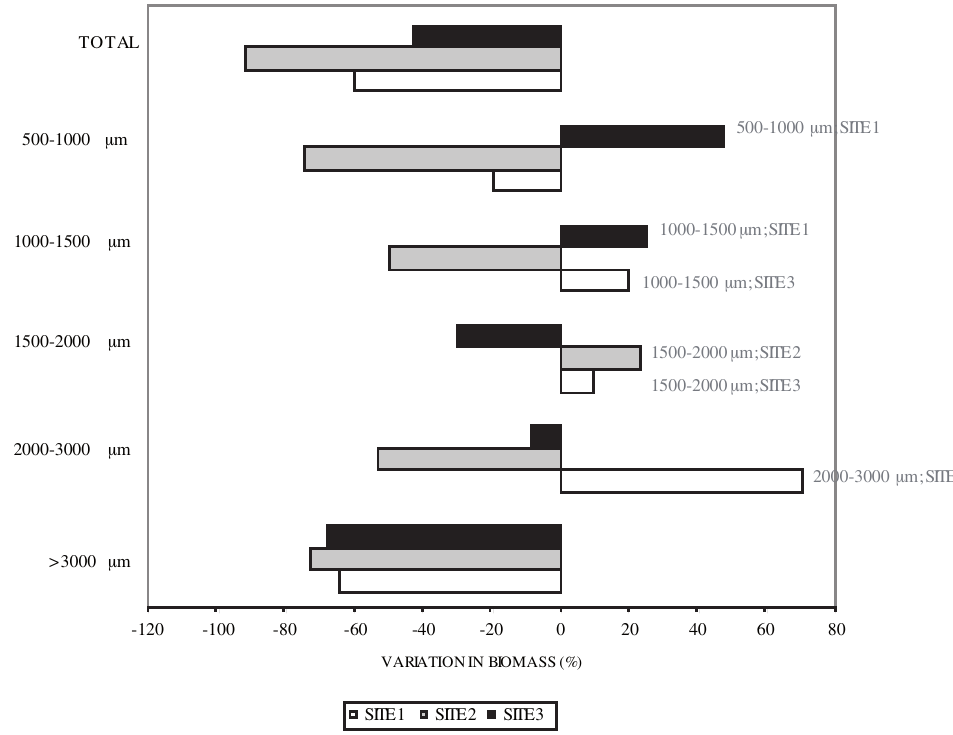
Fig . 11. – Variation in standing stock (biomass) of cockles Cerastoderma edule according to size class, “before” and “after” the cockle har- vesting, which occurred in June